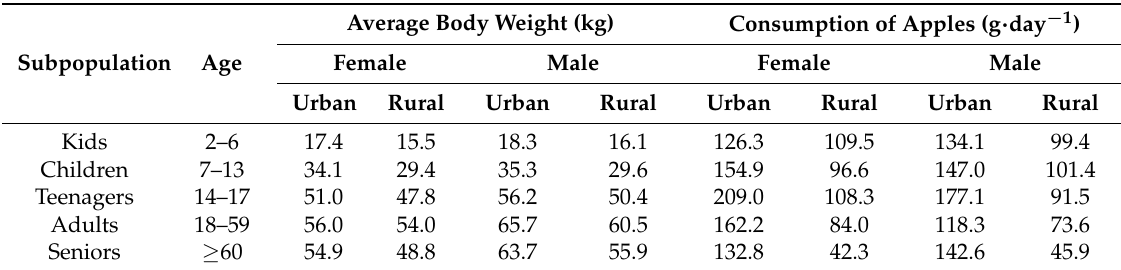
Table 3. Characterization of the population and dietary intake of apples.